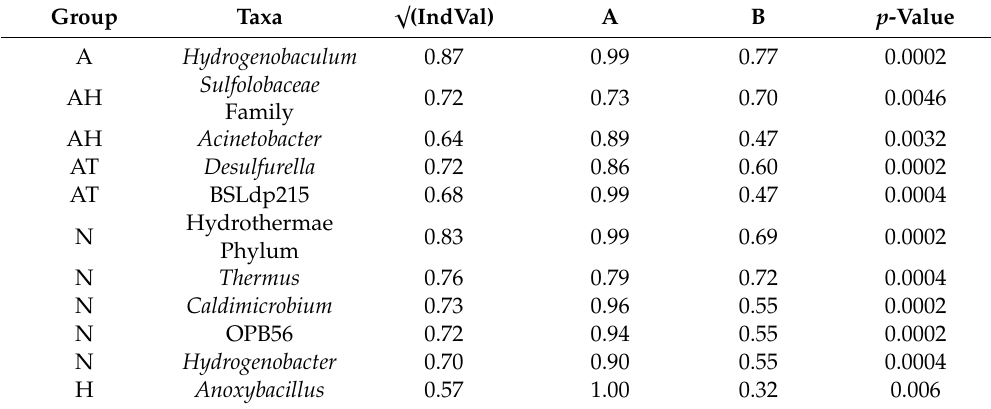
Table 2. Analysis of the occurrence of taxa across site conditions. The square root of the indicator value (IndVal) of the most significative taxa is presented. Components of the IndVal, specificity (A) and fidelity (B), are shown as well. Condition groups are defined as acidic (A), circumneutral (N), thermophilic (T) and hyperthermophilic (H), with combinations being considered. √ Group Taxa (IndVal) A B p -Value A Hydrogenobaculum 0.87